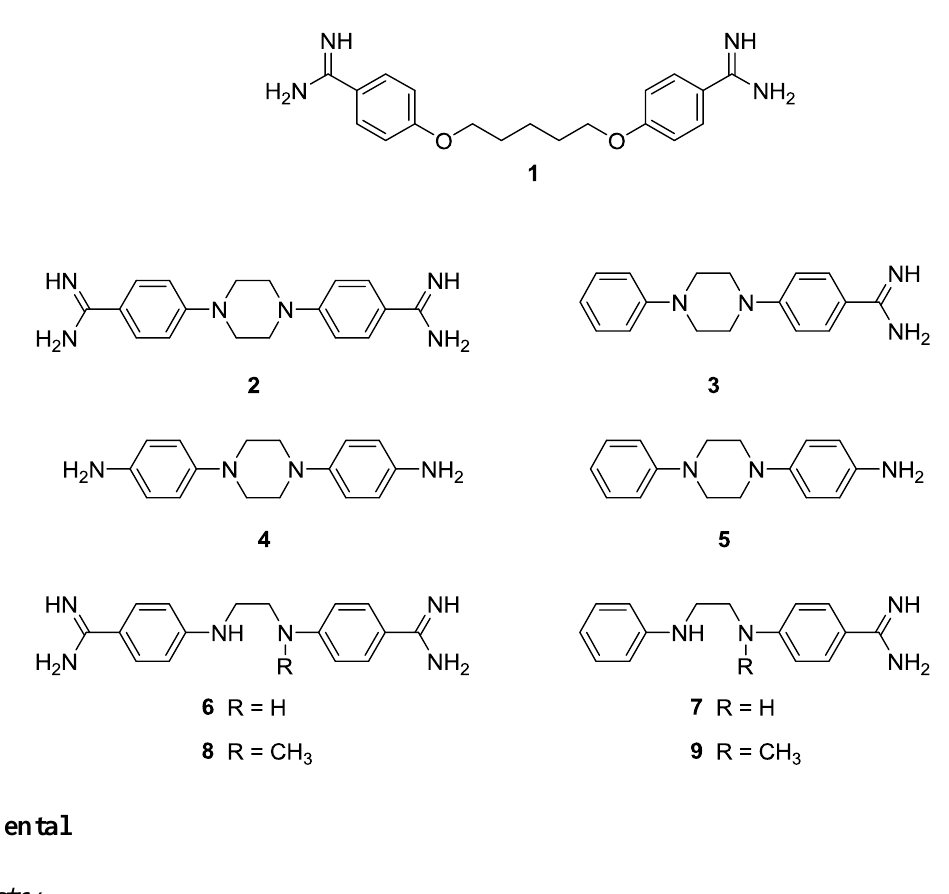
Figure 1. Structure of pentamidine 1 and derivatives 2 – 9 considered in this